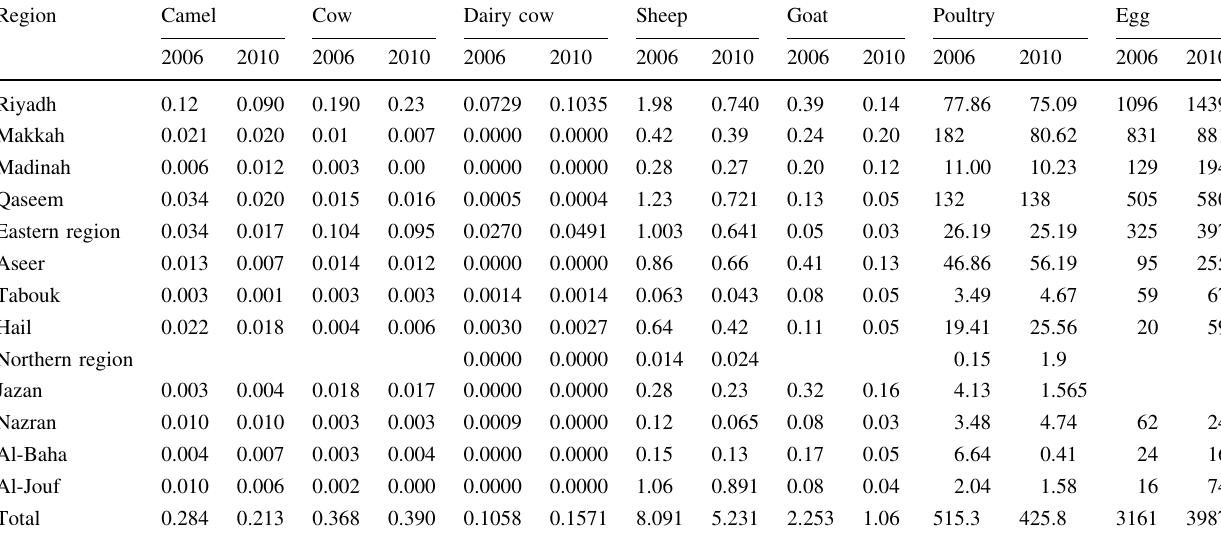
Table 1 Summary of livestock production in Saudi Arabia (in million) Region Camel Cow Dairy cow Sheep Goat Poultry